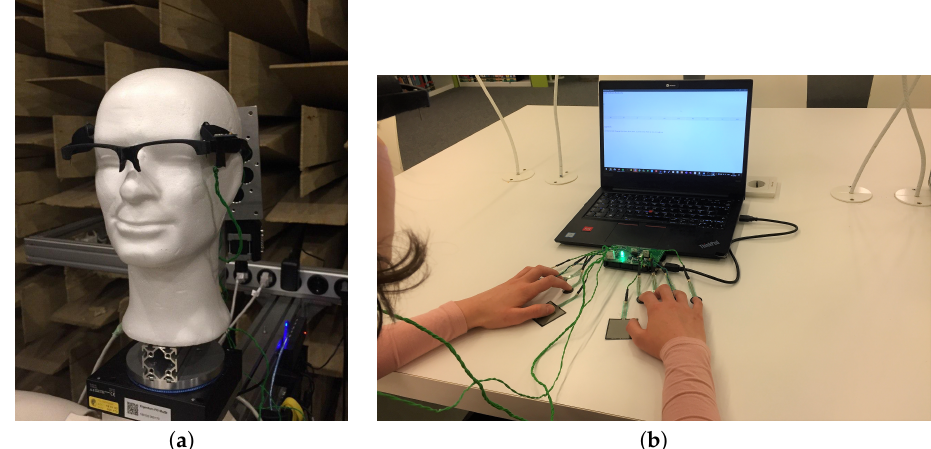
Figure 8. Test setups for assessment of the human–computer interface. To test the human influence on the angle measurement, a reference head movement was performed by a motorized rotation stage. Afterwards, an able-bodied human participant tried to replicate this movement ( a ). Controlling the mouse pointer and entering text with the interface was tested in a pilot experiment with five able-bodied subjects ( b ).